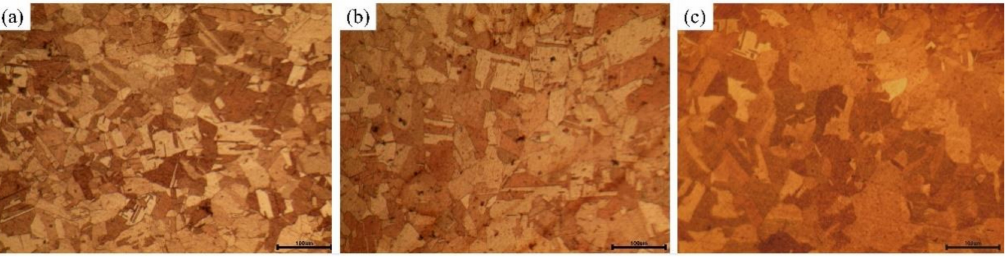
Figure 1. Microstructure of annealed OFHC copper. ( a ) 30 µ m, ( b ) 40 µ m, and ( c ) 60 µ m.